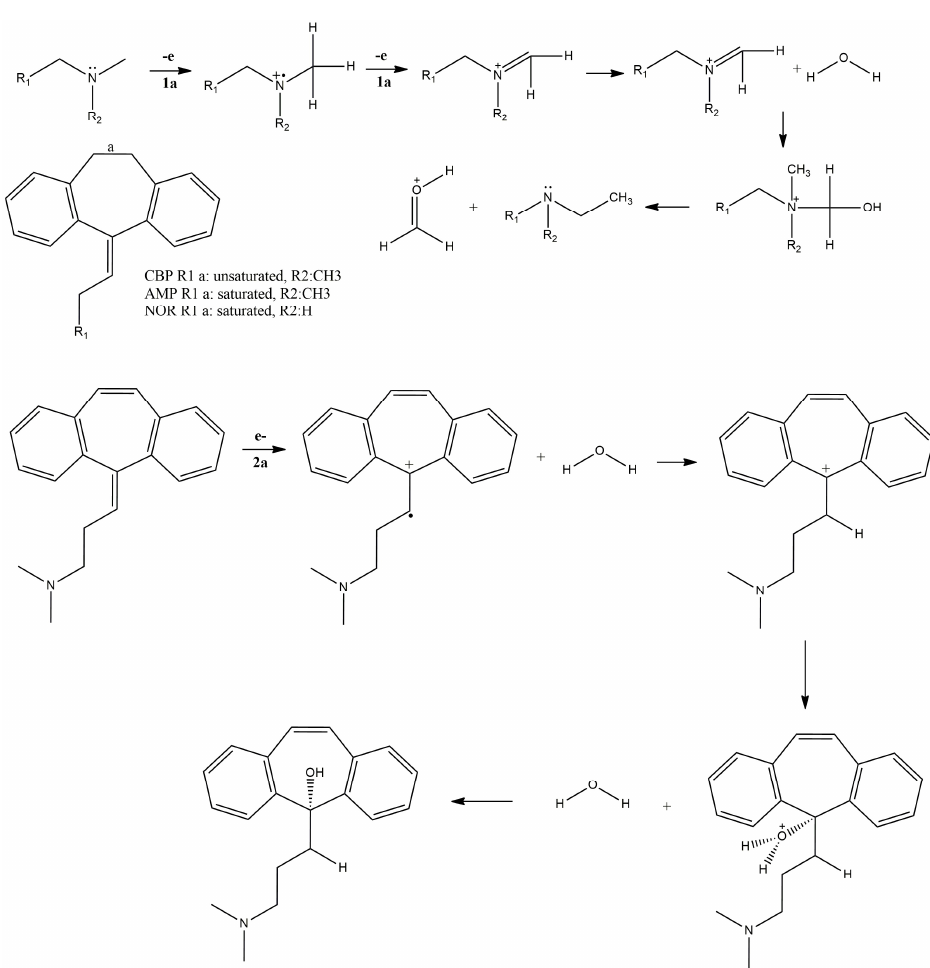
Figure 7. Proposed CBP, AMP and NOR oxidation mechanism.